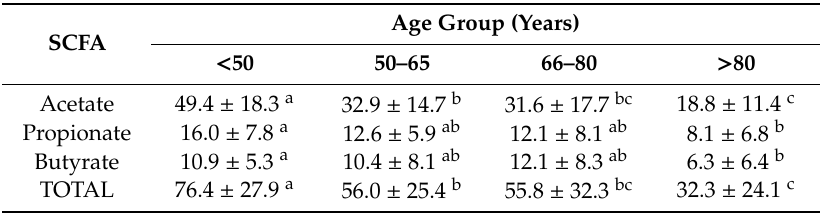
Table 2. Concentration (mM; estimated marginal mean ± SD) of acetate, propionate, butyrate and total short chain fatty acids (SCFAs) (acetate + propionate + butyrate) in fecal samples from volunteers of the di ff erent age